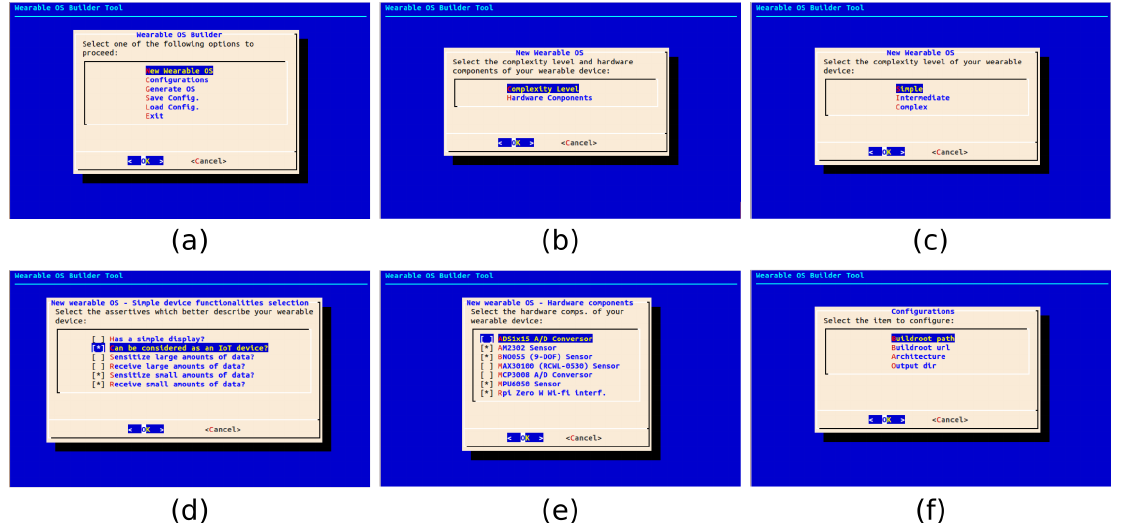
Figure 4. WeCOST screenshots: ( a ) main screen. ( b ) Options selection for “complexity level” and “hardware components”. ( c ) Selection of “complexity level”. ( d ) Example of screen showing assertives of a “simple” wearable device. ( e ) Screen presenting hardware components that can be selected. ( f ) System configurations